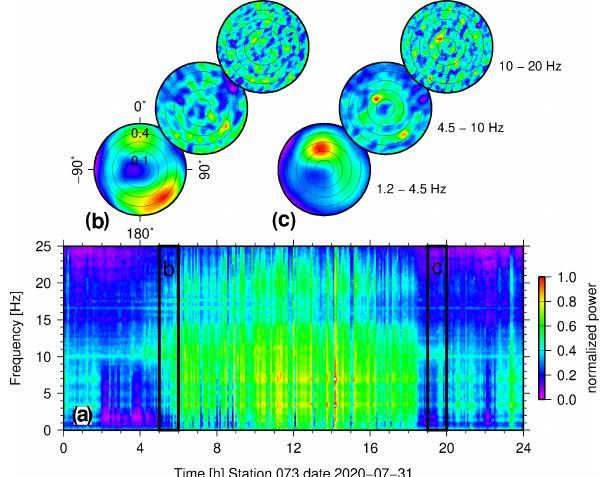
Figure 3. Frequency and directional beam-forming analysis (exem- plary). (a) Spectrogram of data of station 073 at day 31 July 2020 (vertical component). Power spectral density is colour coded. (b, c) Beam-forming analysis within two time windows of 1h in duration between 05:00 and 06:00UTC and 19:00 and 20:00UTC (indicated in a ) using a subset of 22 stations (vertical components). Normalized beam power is colour coded. Radius is slowness in skm − 1 (from 0skm − 1 in the centre to 0.5skm − 1 at the edge), azimuth is the direction from north. For each time window beam- forming analysis has been performed in three frequency ranges 1.2– 4.5, 4.5–10 and 10–20Hz. See text for details.